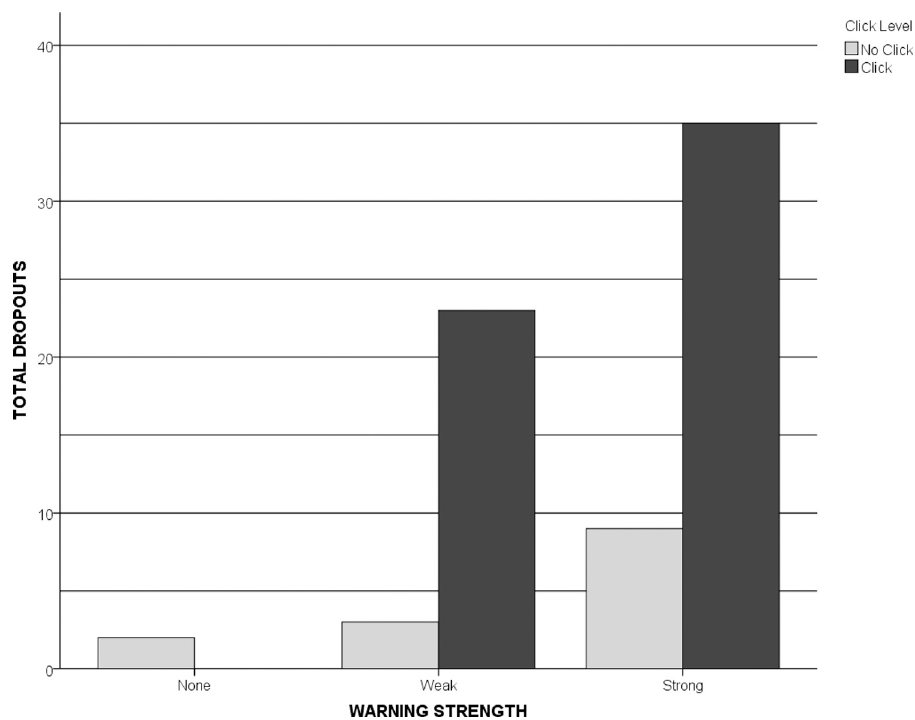
Fig 3. Pattern of dropouts. Written warnings alone drove only a few people away from the study. An added click requirement increased the total number of dropouts substantially (black bars).